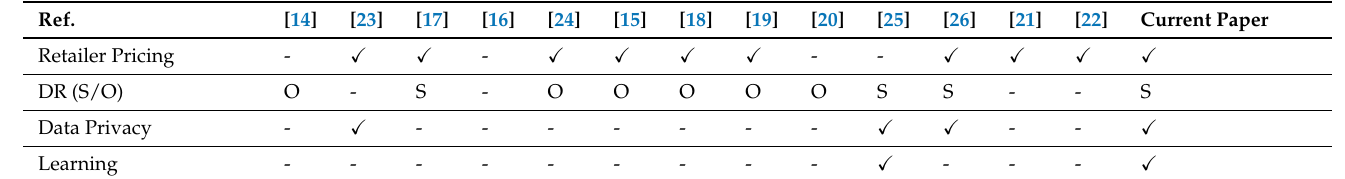
Table 1. A review of papers related to retailer’s pricing in interaction with the end user.